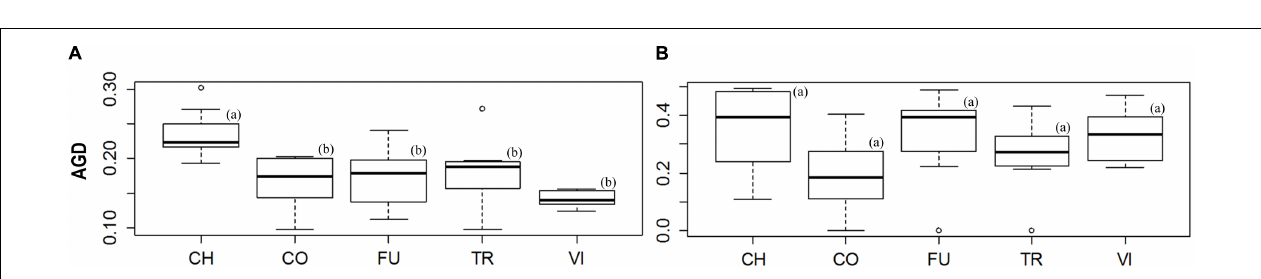
FIGURE 3 | BayeScan plots of 322 (AFLP) loci in 381 samples of P. australis . The line is the threshold [Log (PO) = 0.5] used for identifying outlier loci. Dots that fall over to the threshold line are identified as outlier loci and the dimension in base pairs (bp) was reported.